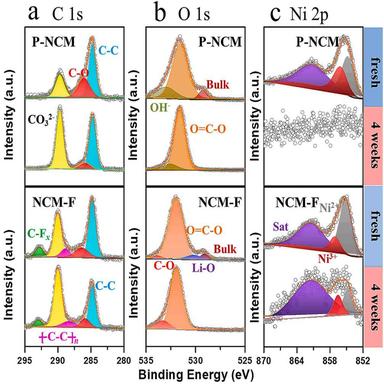
High-resolution XPS spectra of P-NCM, NCM–F, 4-week P-NCM, and 4-week NCM–F: (a) C 1 s spectra; (b) O 1 s spectra; (c) Ni 2p spectra. Fresh materials are displayed in the top, and the samples exposed in air for 4 weeks are displayed in the bottom.